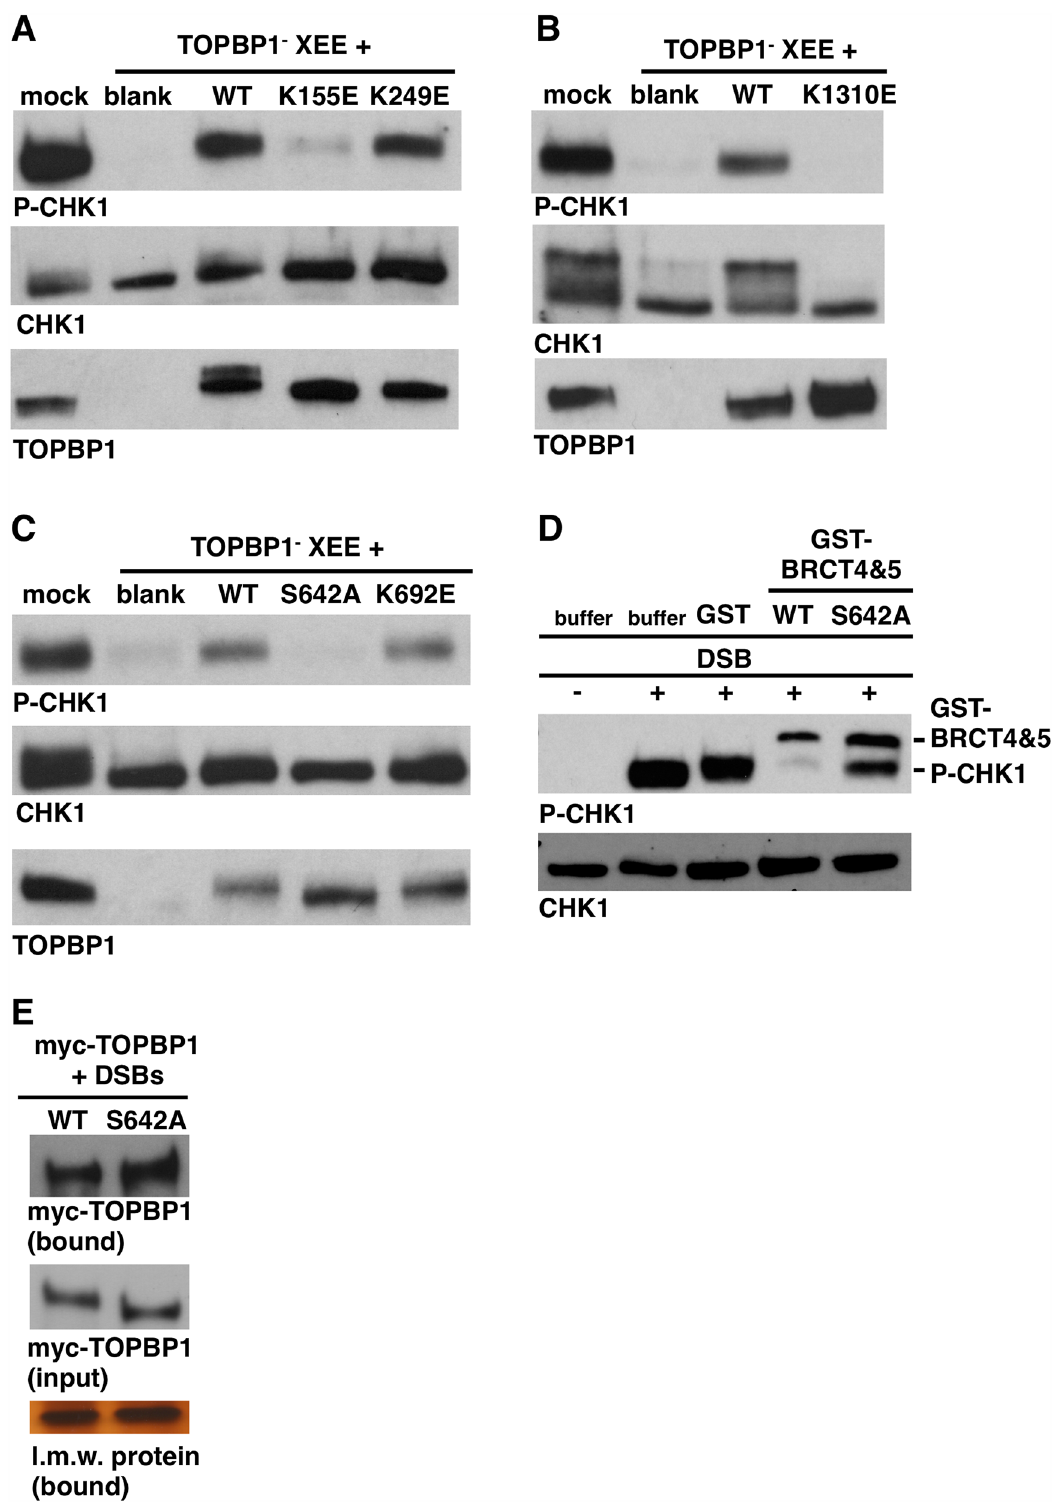
Figure 8. The role of TOPBP1’s PBPs in ATR signaling. A–C Immunodepletion and add-back DMAX assays were performed exactly as in Figs. 2E and 5A–D. The TOPBP1 PTP mutants were analyzed and are indicated above the blots. ( D ) A BRCT overexpression assay was performed using 1 μM of the indicated GST fusion protein. Samples were processed exactly as in Fig. 6. The GST-BRCT4&5 protein itself cross-reacts with some batches of the P-CHK1 antibody, and this band is labeled. ( E ) DSB binding assay with the indicated proteins. Samples were processed exactly as in Fig.